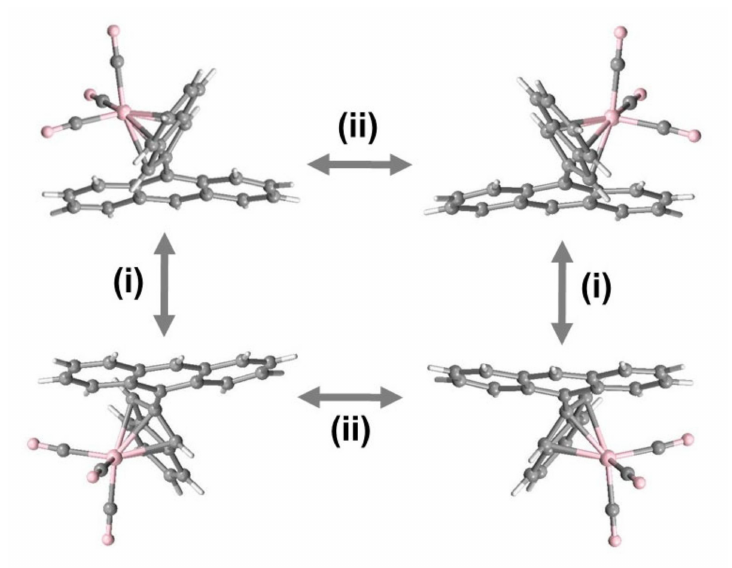
Figure 13. Exchange behaviour in the indenyl-anthracene rhenium complex 29 . ( i ) Low-energy (C s symmetric) up / down oscillation of the indenyl-Re(CO) 3 group relative to the anthracene ring plane; ( ii ) higher-energy process whereby side-to-side rotation of the indenyl-Re(CO) 3 moiety about the C(9)-indenyl linkage equilibrates the terminal benzo rings.